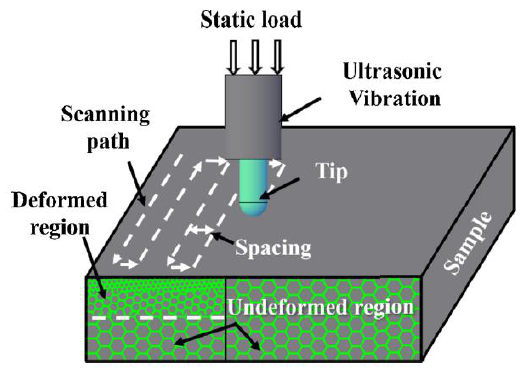
Figure 4. Illustration of UNSM treatment. Reprinted with permission from Ref. [23]. Copyright